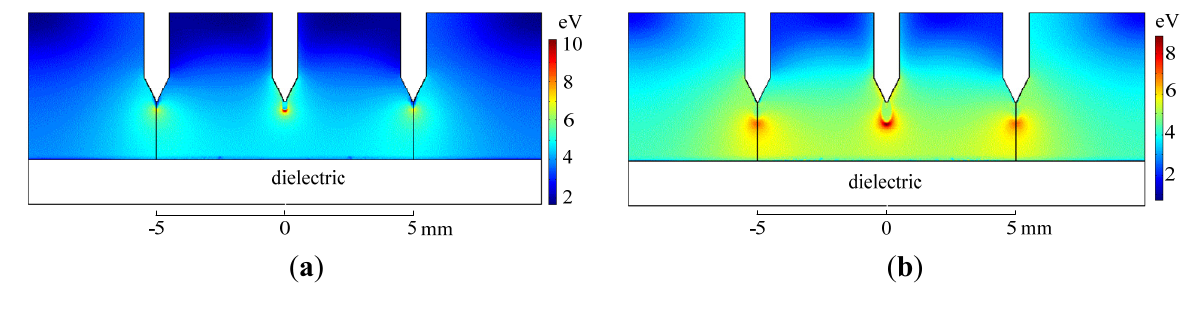
Figure 12. Electron average energy profile over the axial cross section of the